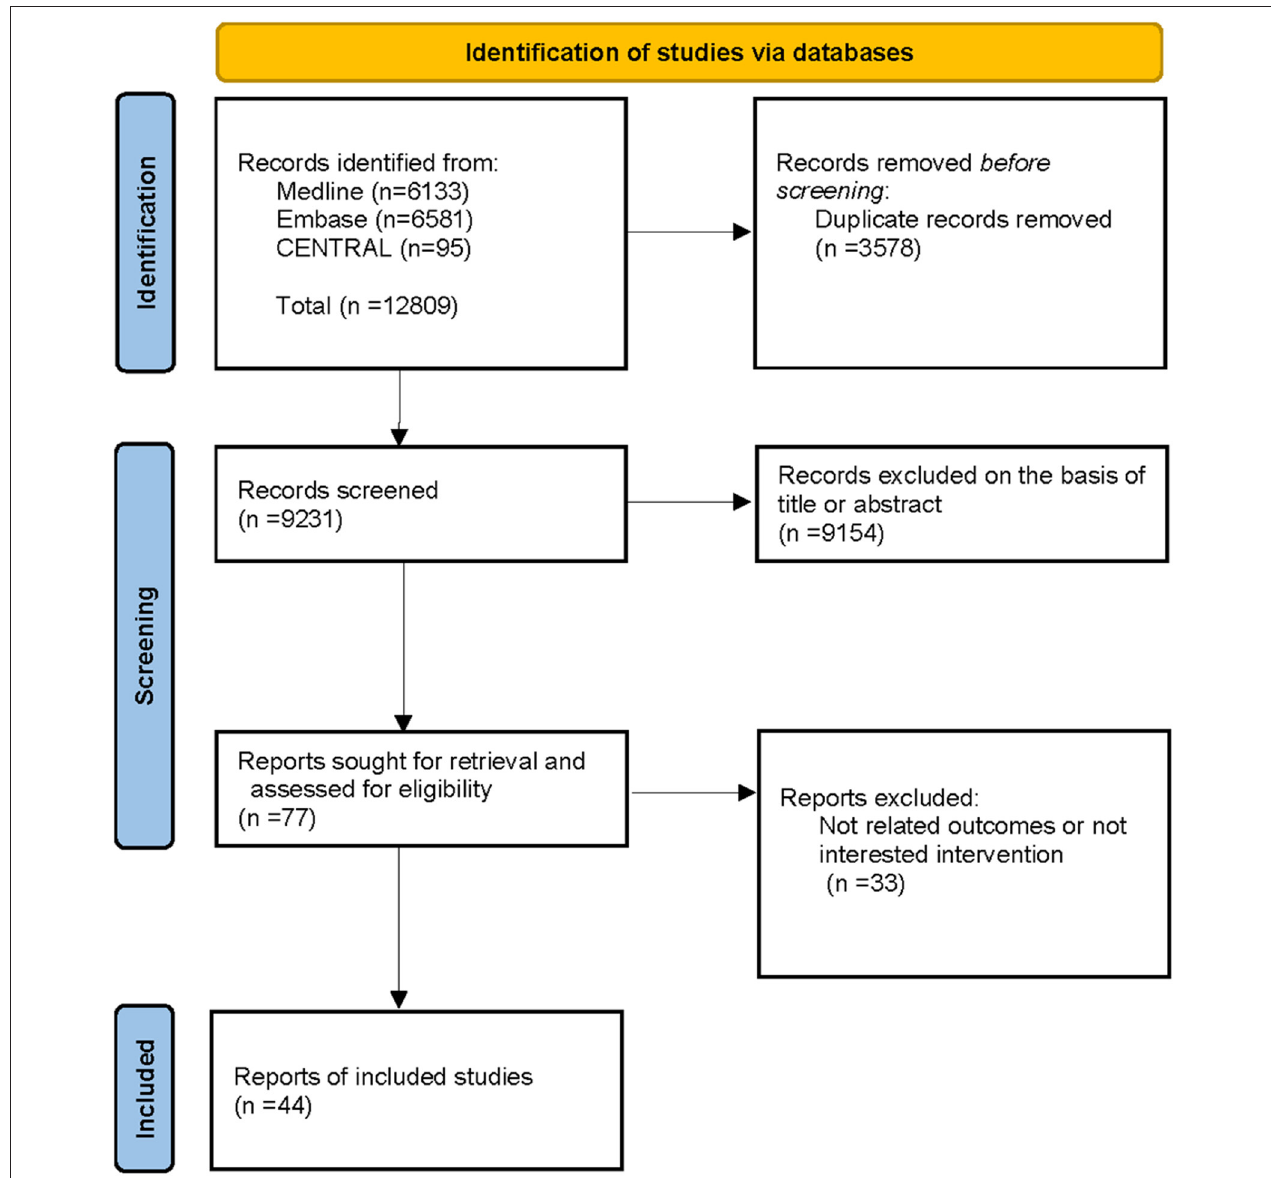
FIGURE 1 | Flowchart of the study